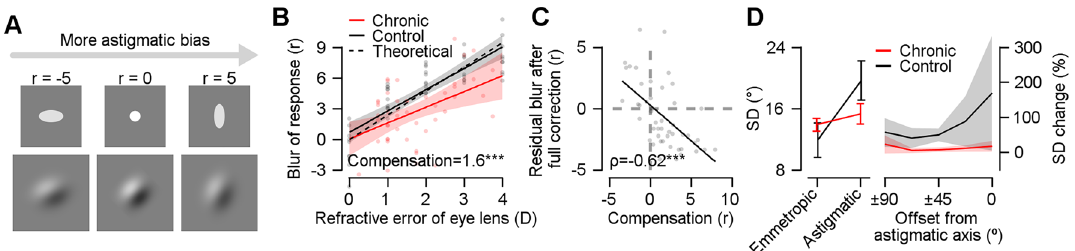
Figure 3. Automatic compensation of astigmatic distortion after chronic exposure. ( A ) The amount of optical blur ( r ) was estimated using the point spread function model. If the r value increases (as r = 5), a Gabor stimulus would be distorted to exhibit more astigmatic bias, and if the r value decreases (as r = − 5), it would be distorted to show the opposite bias, compared to emmetropia ( r = 0). ( B ) The amount of optical blur ( r ) estimated in perceptual bias was plotted as a function of the physical refractive error of the eye in diopter ( D ). Dots and solid lines represent the r value of each eye and the linear regression line of each group. The shaded areas indicate ± 95% confidence intervals from bootstrapping. The amount of compensation indicates the mean vertical distance between the regression line of the control group (black line) and each red dot (*** p < 0.001). ( C ) The relationship between the residual optical blur after fully correcting the refractive errors of the eyes and the amount of compensation of astigmatism. Rho indicates Spearman’s correlation coefficient (*** p < 0.001). The solid line indicates the result of linear regression. ( D ) Standard deviations (SD) for each emmetropic and astigmatic vision condition and each group (left panel). The percent SD change in the astigmatic vision condition compared with the emmetropic condition for each orientation (right panel). The error bars and the shaded areas indicate ± 2